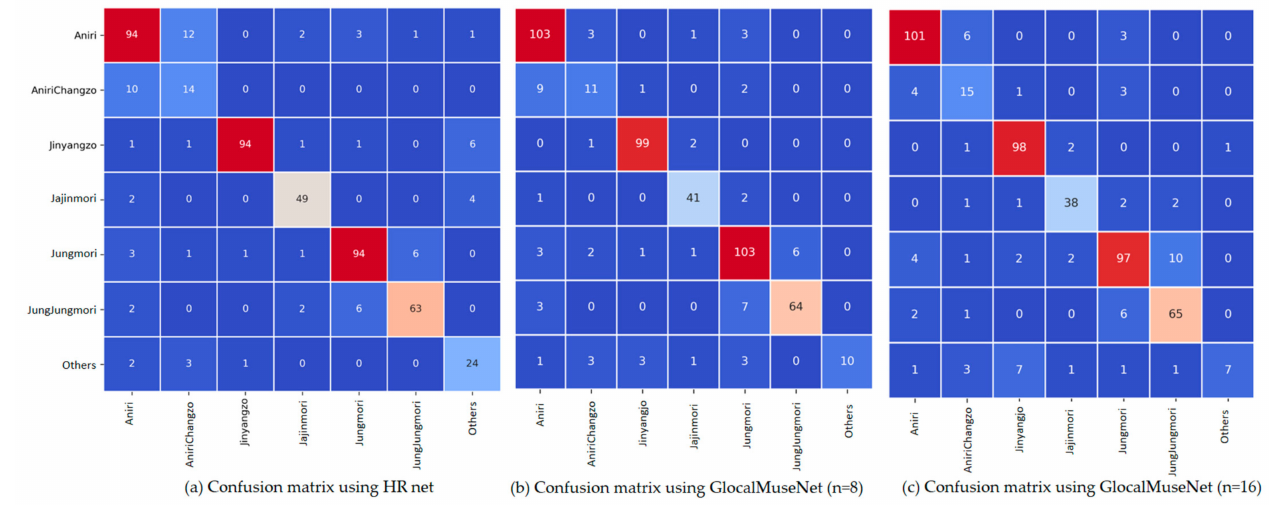
Figure 3. Confusion matrix of our three classifiers using Pansori classification dataset of seven classes.